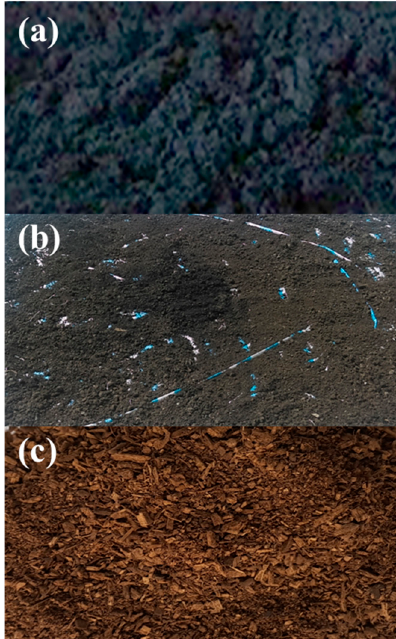
Figure 1. Photographs of different fuels: ( a ) original sewage sludge; ( b ) sun-drying process; ( c ) shiitake growing substrate.